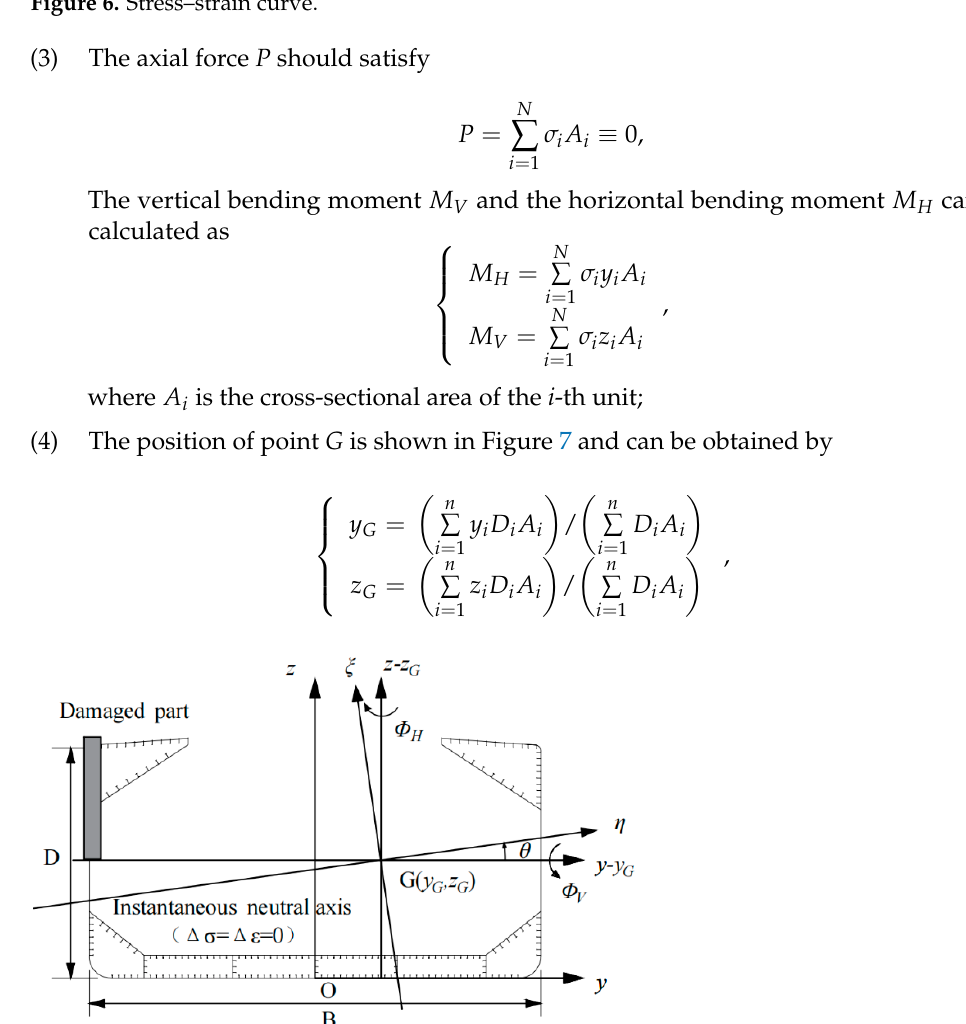
Figure 6. Stress–strain curve.